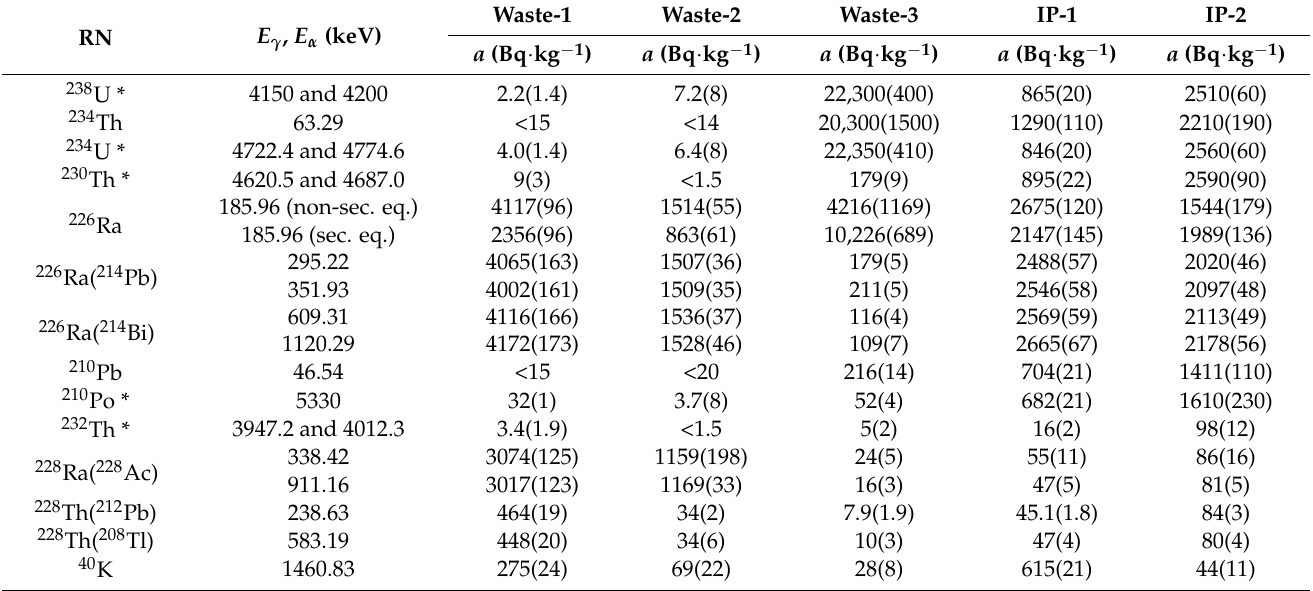
Table 4. Activity concentrations obtained for gamma-ray and pure-alpha emitters contained in several wastes (from Waste-1 to Waste-3) and intermediate products (IP-1 and IP-2), where E γ and E α are the emissions selected in order to determine the gamma-ray and pure-alpha emitters, respectively. Furthermore, in the case of the 226Ra (186 keV), two cases were taken into account: considering and without considering secular equilibrium between 238U and 226Ra (sec. eq. and non-sec. eq., respectively). Uncertainties are given at 1 sigma level. (*) Radionuclides determined using alpha-particle